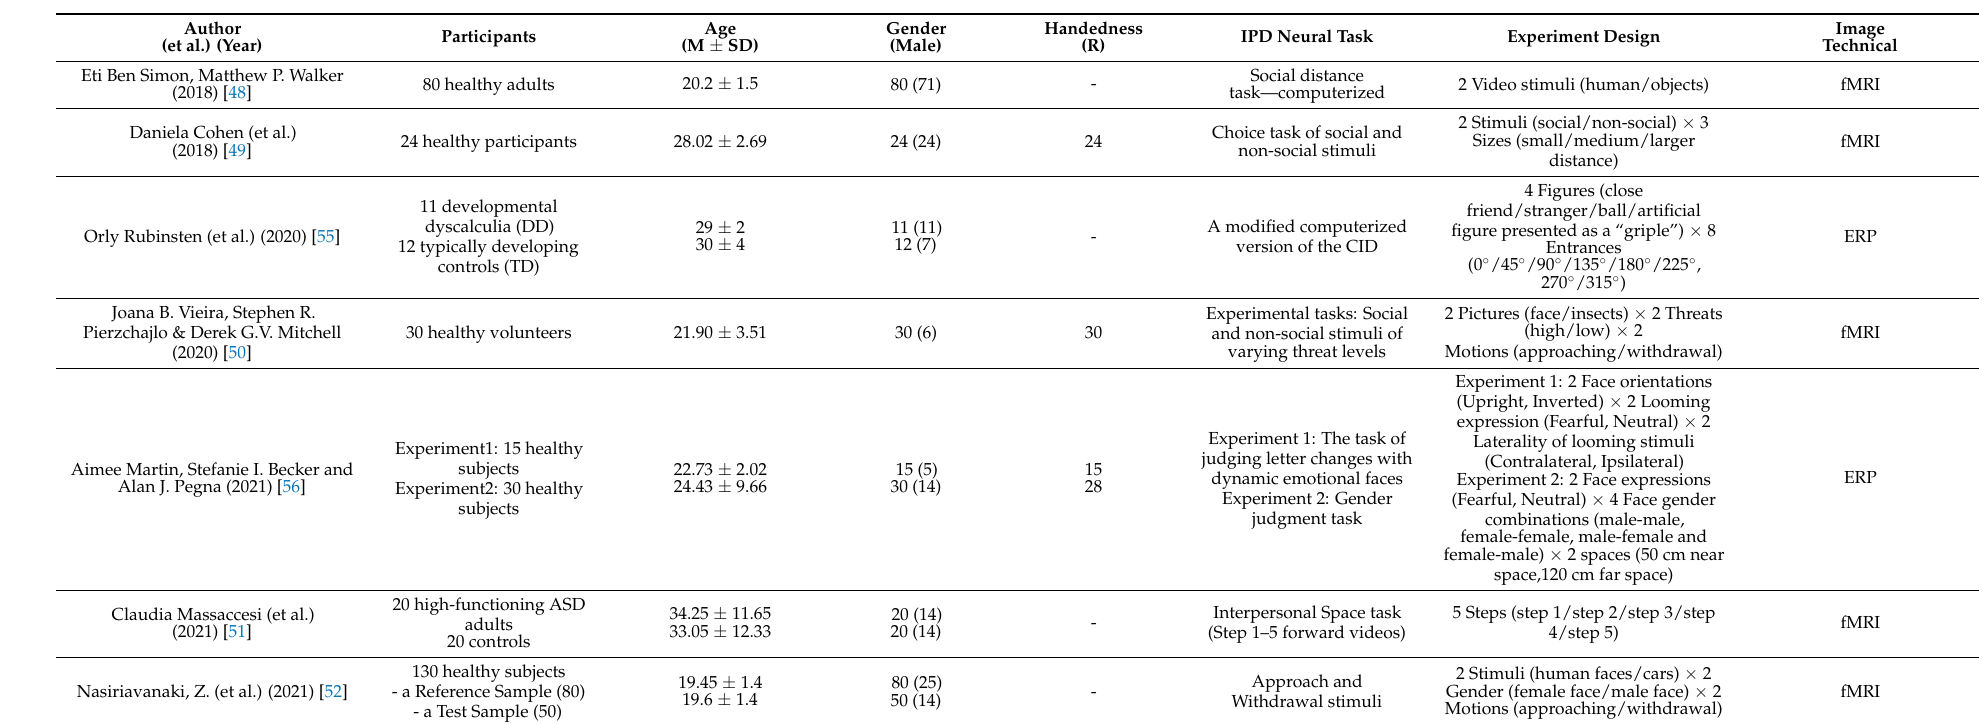
Interpersonal Space task (Step 1–5 forward videos) 2 Stimuli (human faces/cars) × 2 Gender (female face/male face) × 2 Motions (approaching/withdrawal)